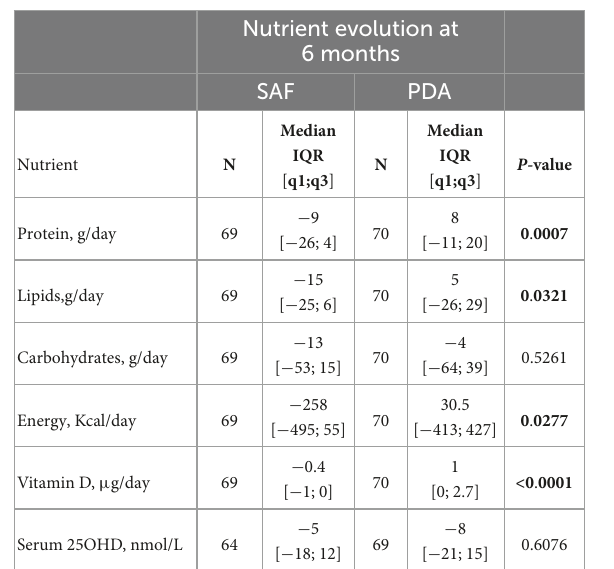
TABLE 5 Daily nutrients intake evolution over 6 months.